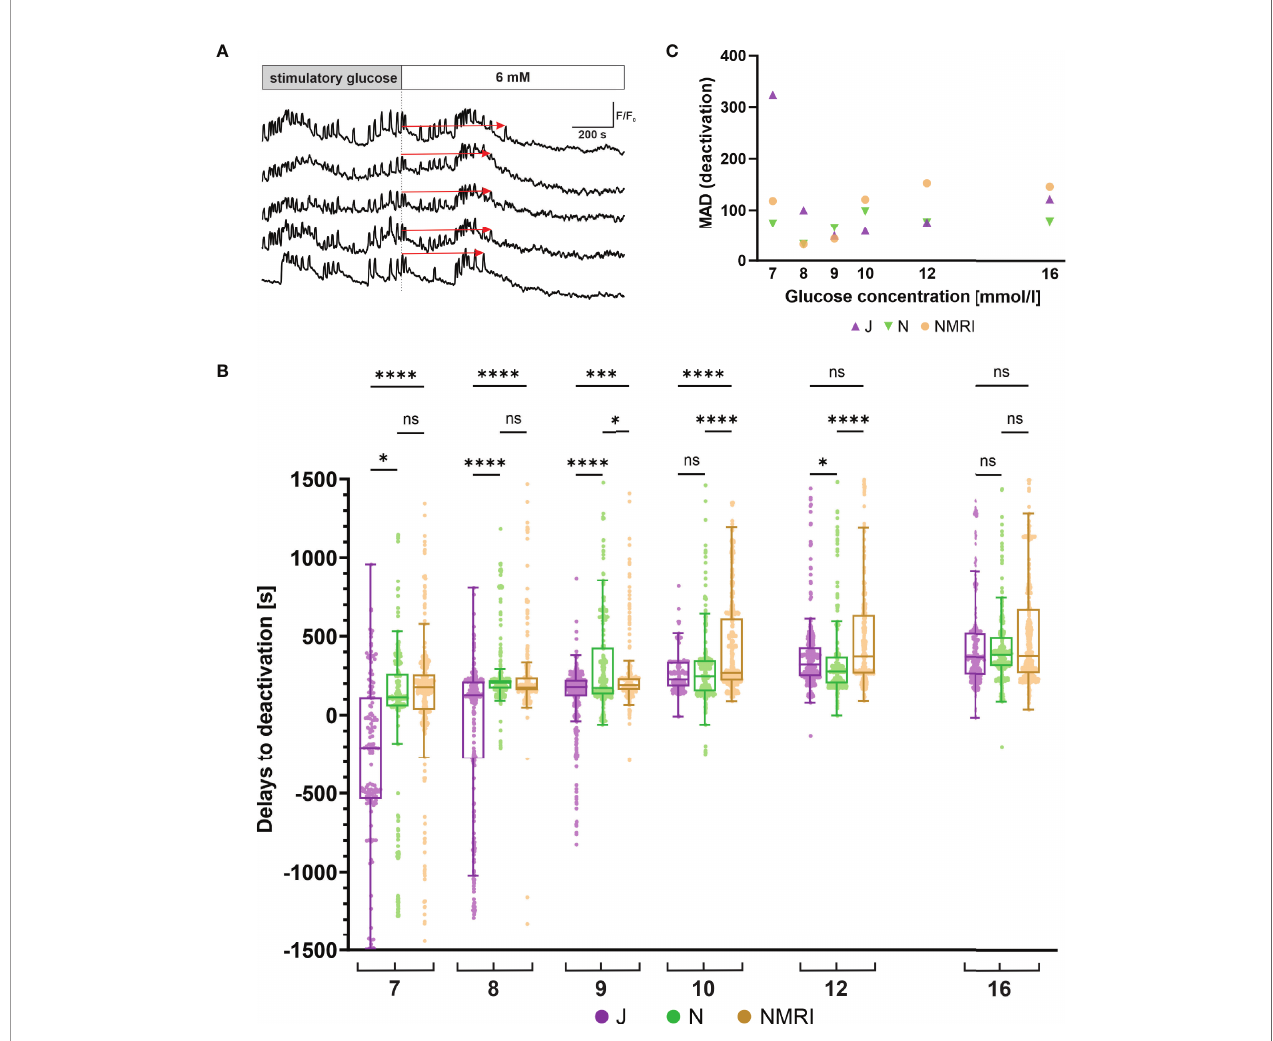
FIGURE 4 | Glucose-dependent deactivation delays of beta cells in C57BL/6J, C57BL/6N and NMRI strains. (A) Schematic representation of delays to deactivation (red arrow) measured as the time difference between end of stimulation (dashed line) and the last [Ca 2+ ] i oscillation. (B) Delays to deactivation in C57BL/6J (median -208, 126, 179, 227, 322, and 370 s), C57BL/6N (median 113, 206, 173, 248, 277, and 386 s), and NMRI (median 178, 175, 190, 269, 373, and 378 s) in 7-, 8-, 9-, 10-, 12-, and 16-mM glucose, respectively. (C) Variability in deactivation delays, expressed as median absolute deviation (MAD) after stimulation with 7-, 8-, 9-, 10-, 12-, and 16-mM glucose. MAD values (in seconds): C57BL/6J: 324 (7 mM), 100 (8 mM), 49 (9 mM), 59 (10 mM), 77 (12 mM), and 120 (16 mM), C57BL/6N: 74 (7 mM), 32 (8 mM), 65 (9 mM), 98 (10 mM), 76 (12 mM), and 77 (16 mM), NMRI: 118 (7 mM), 32 (8 mM), 43 (9 mM), 121 (10 mM), 153 (12 mM), and 145 (16 mM). Pooled data (coded as